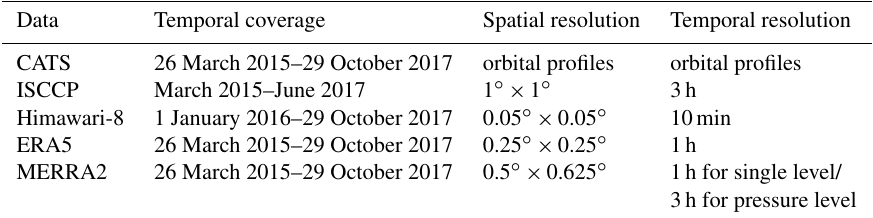
Table 1. The temporal coverage and resolution of datasets used in this study. The temporal coverage of all CMIP6 model outputs is